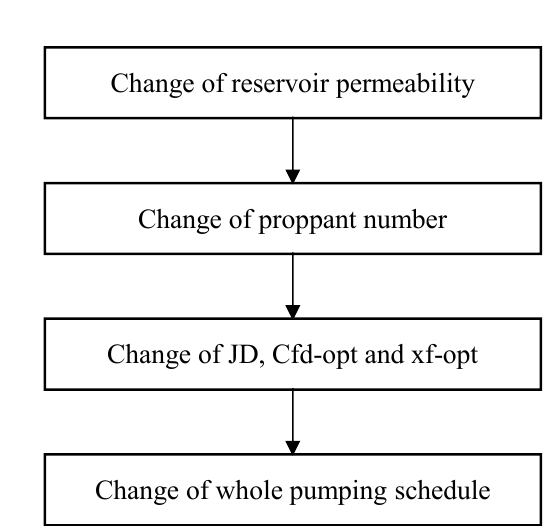
Figure 2—Fracture profile of base case.